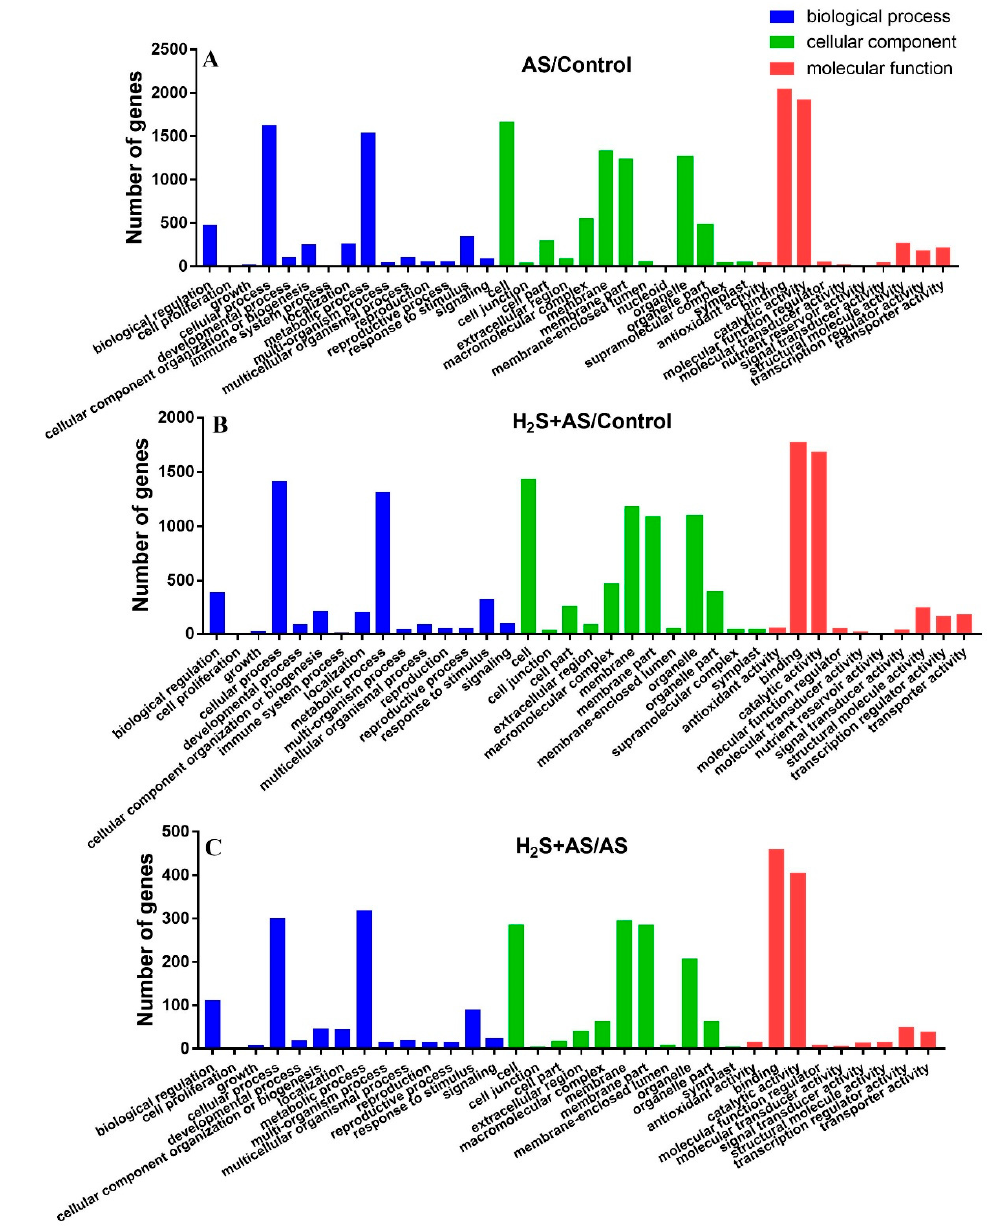
Figure 3. Gene ontology classification of differentially expressed genes. Blue, green, and red represent three GO ontologies: biological process, cellular component, and molecular function,